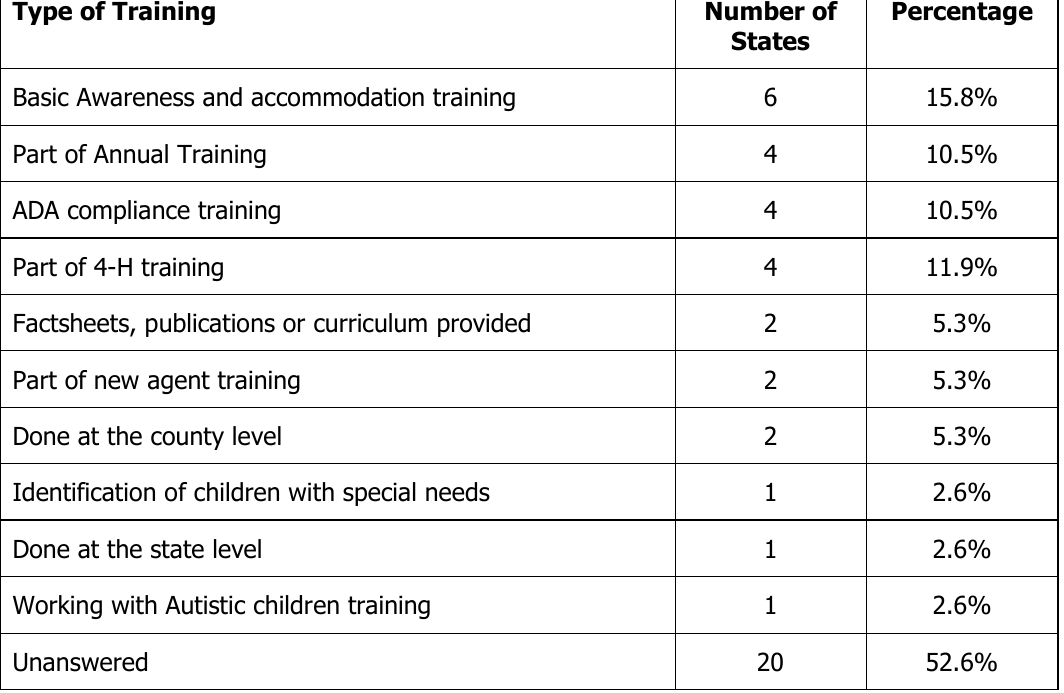
Types of Training Options for Agents/Volunteer